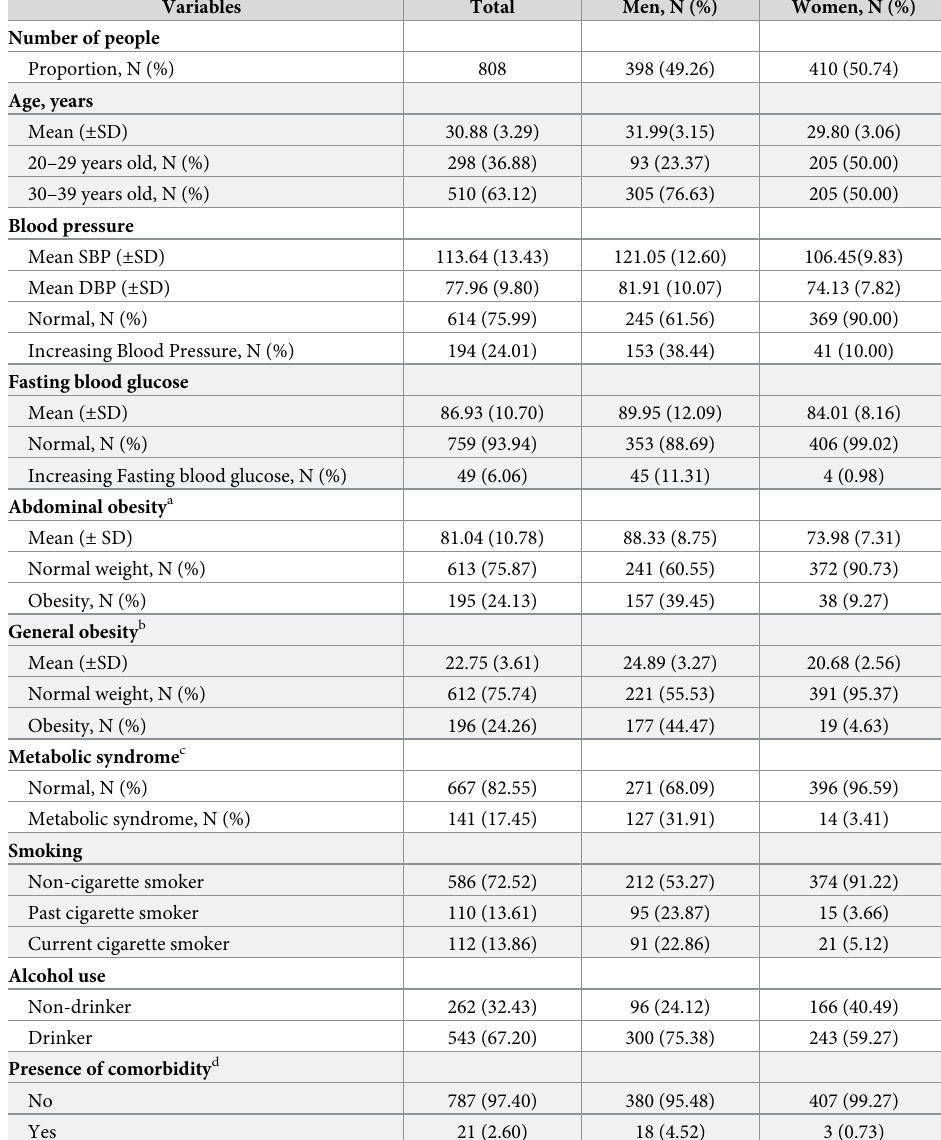
Table 1. Descriptive characteristics of study